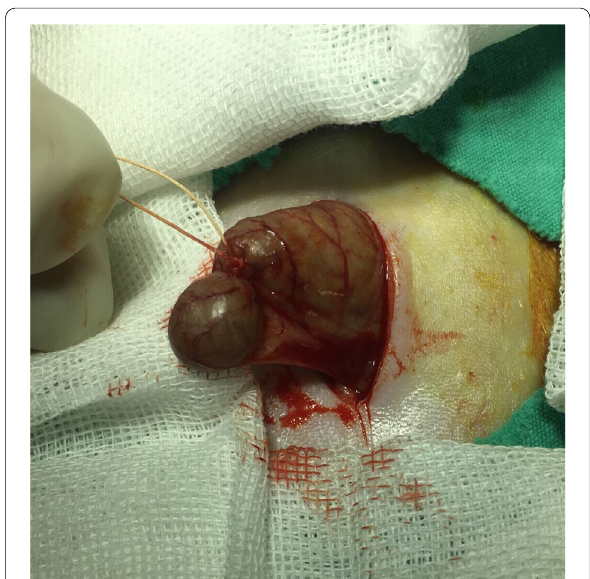
Fig. 1 The appendicitis model was obstructed with a small area vessel distal to the caecum and filled with cecal material. The suture was loosely bound so as not to disturb the circulation of the cecum